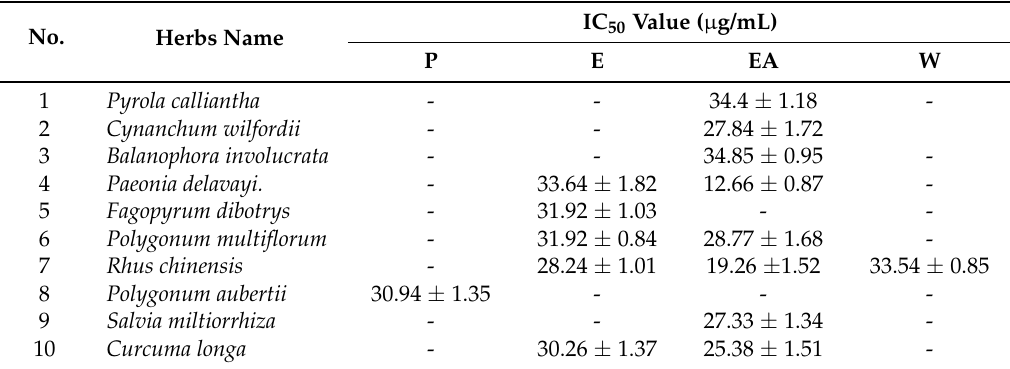
Table 2. IC 50 values for NA inhibitors of the petroleum ether, ethanol, ethyl acetate, and aqueous extracts from 10 traditional Chinese